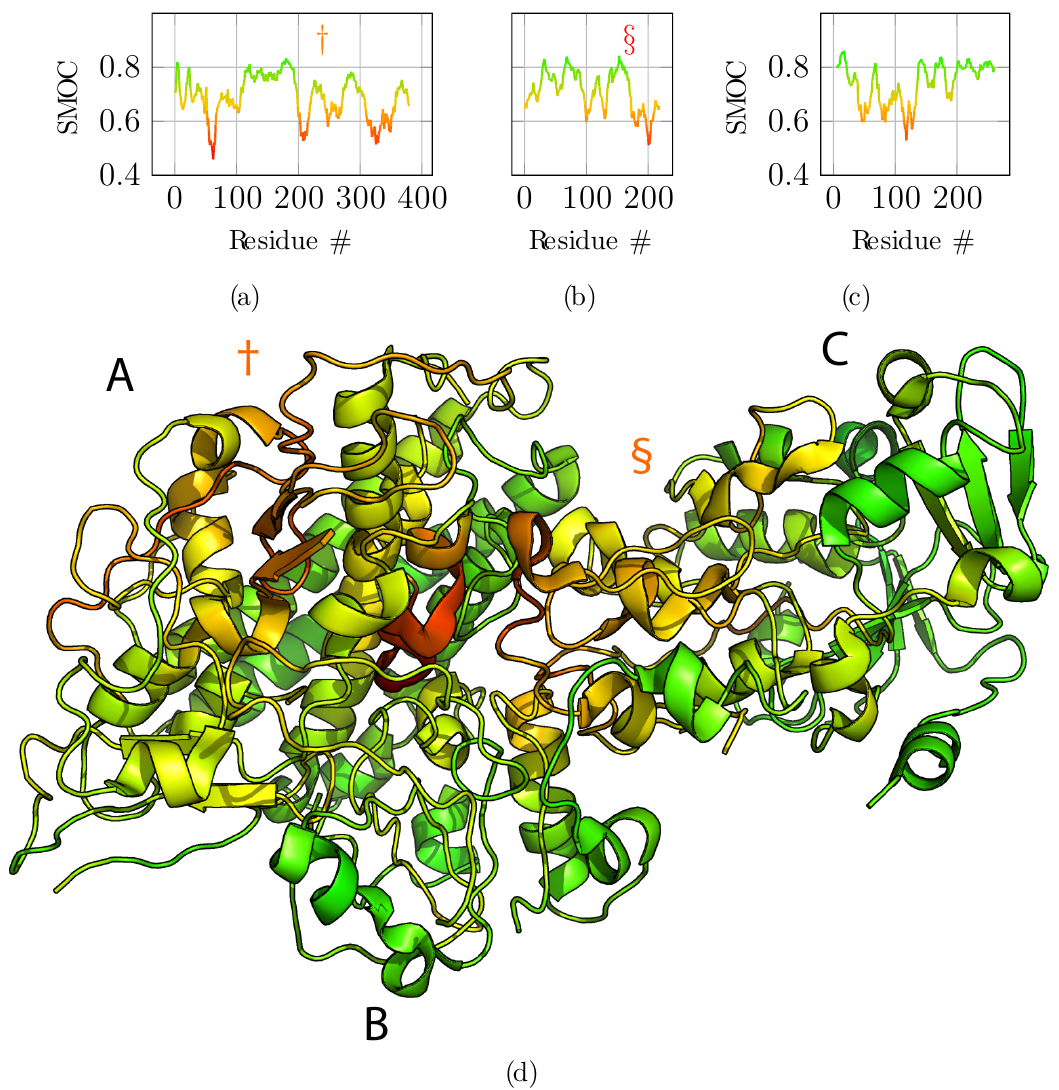
Figure 6. Segment Manders’ overlap coefficient (SMOC) of the refined model against the EM density map EMD-2513 used as input for the atomic scale reconstruction method. ( a – c ) SMOC profiles along the protein sequence of chain A, B, and C, respectively. ( d ) The corresponding SMOC values are projected on the obtained full-atom model. The color scale highlights poorly fitted regions in red. Symbols †and § indicate two of the tree regions previously identified as having high deviation from the reference